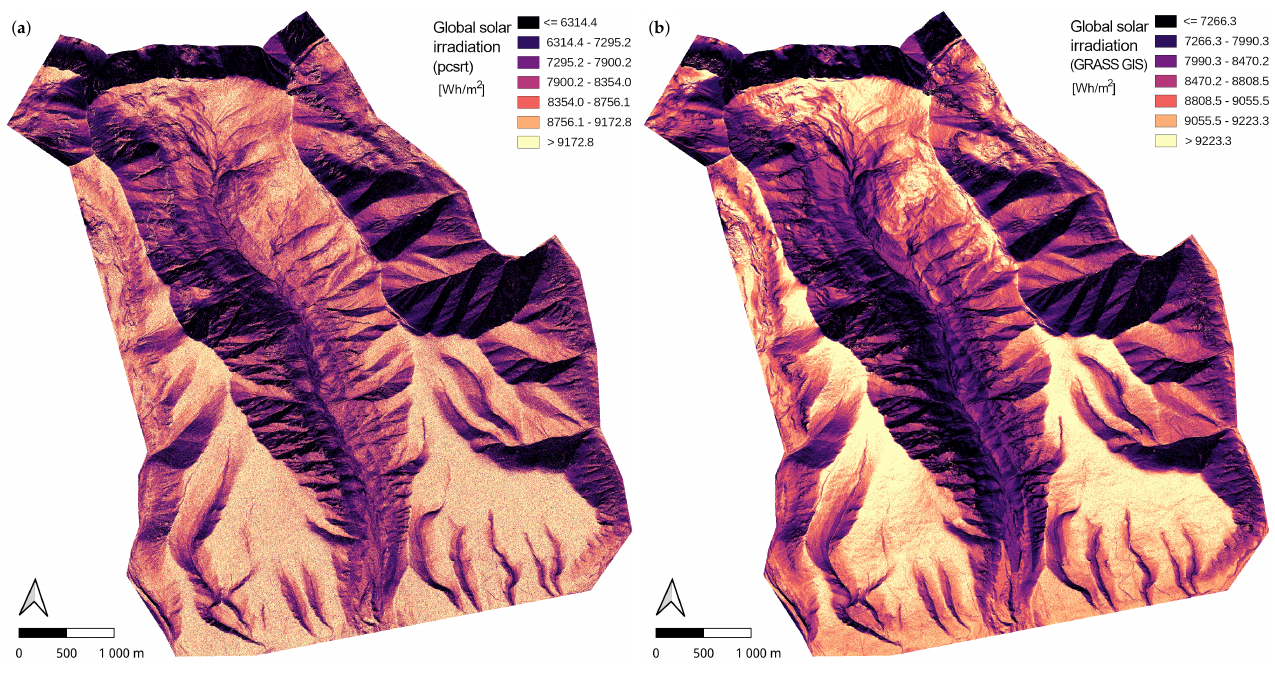
Figure 7. Comparison of the daily-cumulative global solar radiation for the 21 June 2022 on the DEM of the Kamenistá valley (Slovakia) from ( a ) pcsrt and ( b ) r.sun in GRASS GIS visualized using quantiles in QGIS. Data source: ÚGKK SR [43].